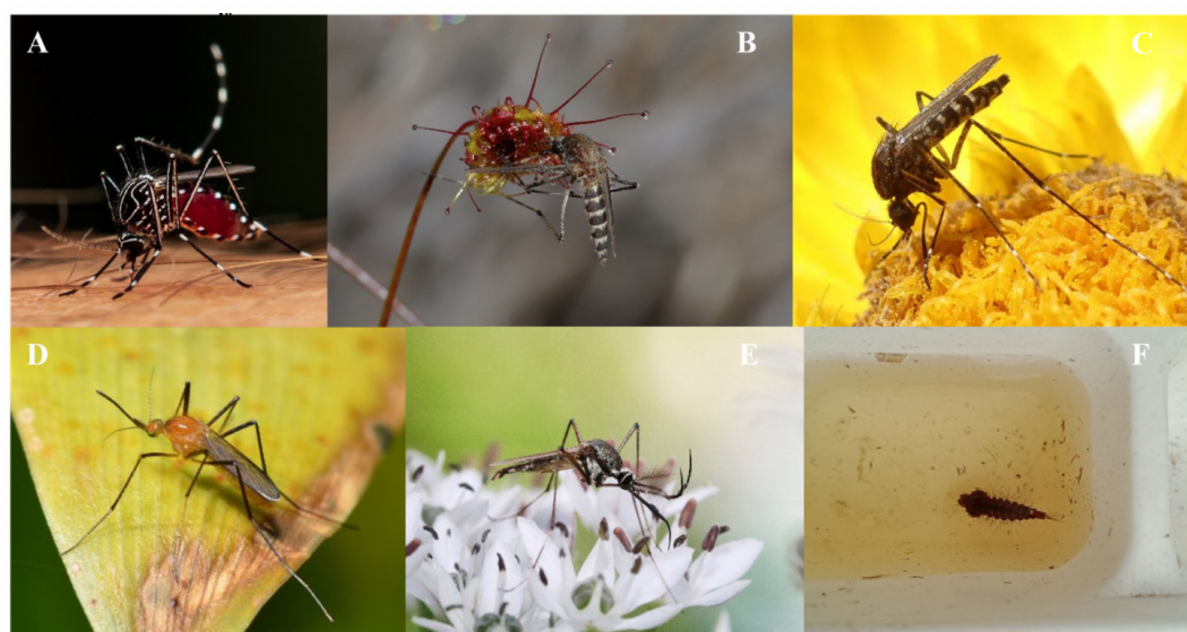
Figure 4. Most common species shared on Mozzie Monitors on iNaturalist with iNaturalist pho- tographer credit. ( A ) Aedes notoscriptus © Jacky Lien, ( B ) Aedes camptorhynchus © frank_prinz, ( C ) Aedes vigilax © Jeannie, ( D ) Coquillettidia xanthogaster © Dianne, ( E ) Toxorhynchites speciosus © Sylvia Alexander, ( F ) Larva of Toxorhynchites speciosus © Gillian Fitzgerald. Photos A-F have Creative